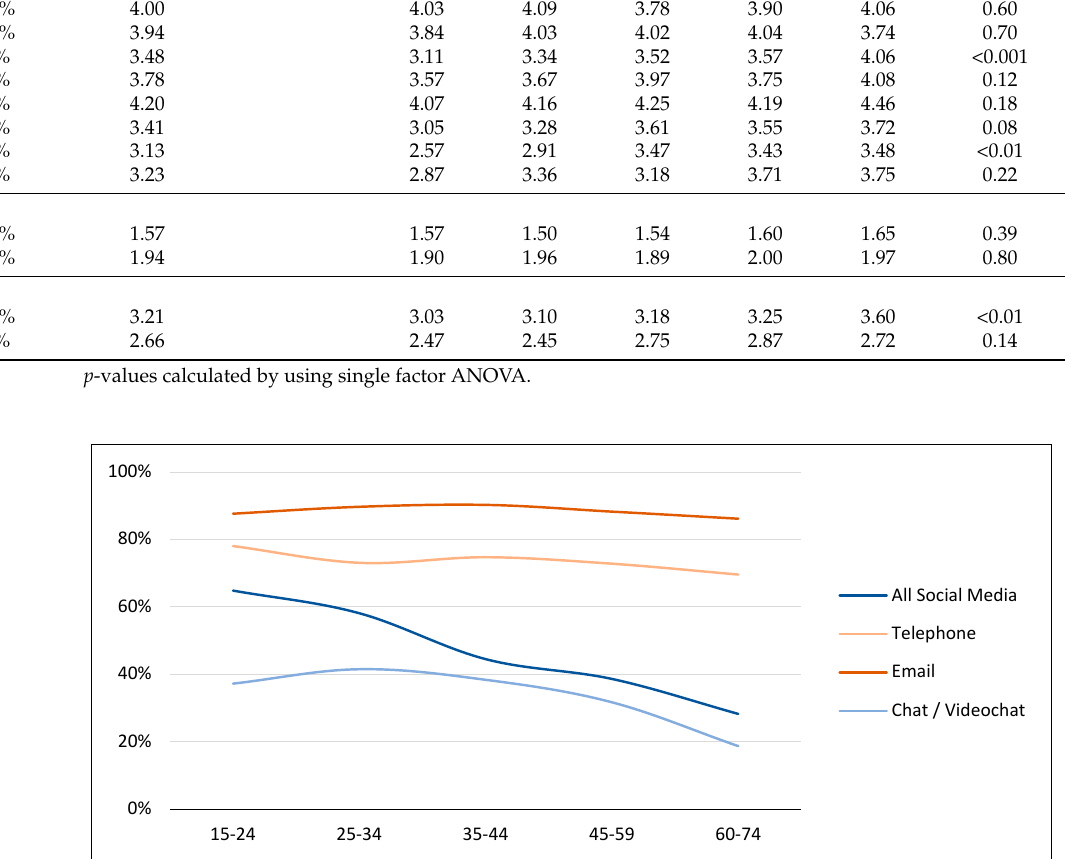
Figure 1. Positive opinion (1–2) on communication from insurer by age cohort.